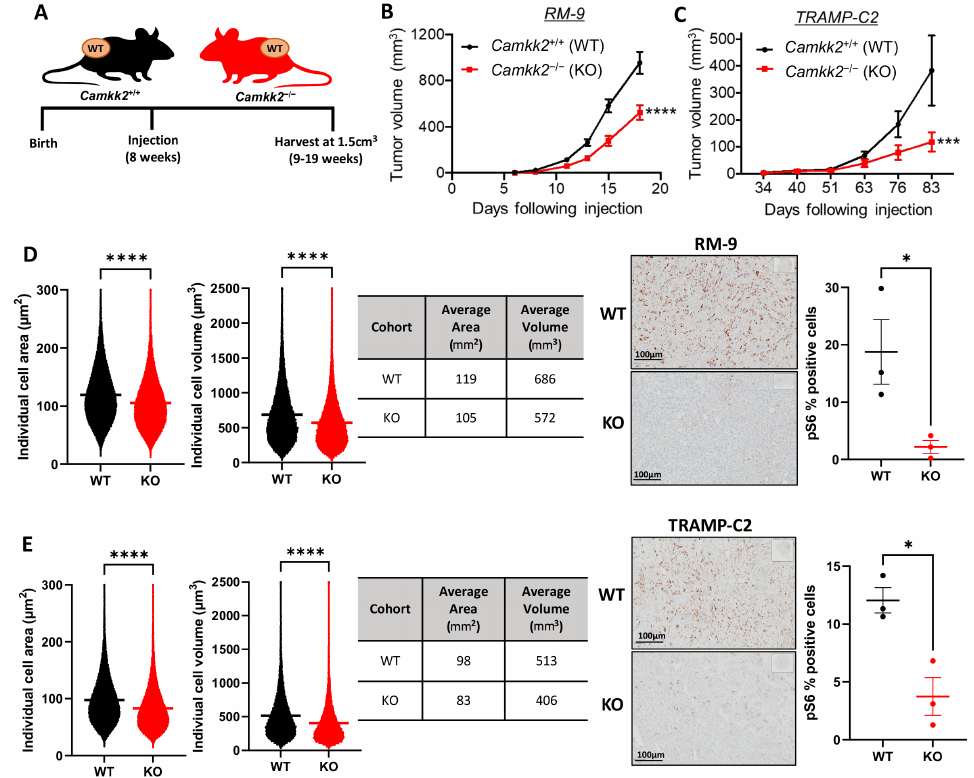
Figure 6. Host Camkk2 ablation decreased tumor growth, cancer cell size, and mTOR signaling in syn- geneic mouse models of prostate cancer. ( A ) Schema for syngeneic mouse experiment. C57BL6 RM-9 ( B ) and TRAMP-C2 ( C ) murine prostate cancer cells were subcutaneously injected into syngeneic Camkk2 +/+ and Camkk2 − / − host mice and tumor growth was monitored over time (RM-9/ Camkk2 WT n = 12; RM-9/ Camkk2 KO n = 9; TRAMP-C2/ Camkk2 WT n = 10; TRAMP-C2/ Camkk2 KO n = 11). ( D ) RM-9 and ( E ) TRAMP-C2 average cell areas and average cell volumes were quantified from harvested tumors (left). In addition, % positive staining of p-S6 in syngeneic tumors (WT n = 3, KO n = 3) was quantified (right). ns = not significant; * p < 0.05, *** p < 0.001, **** p < 0.0001. For